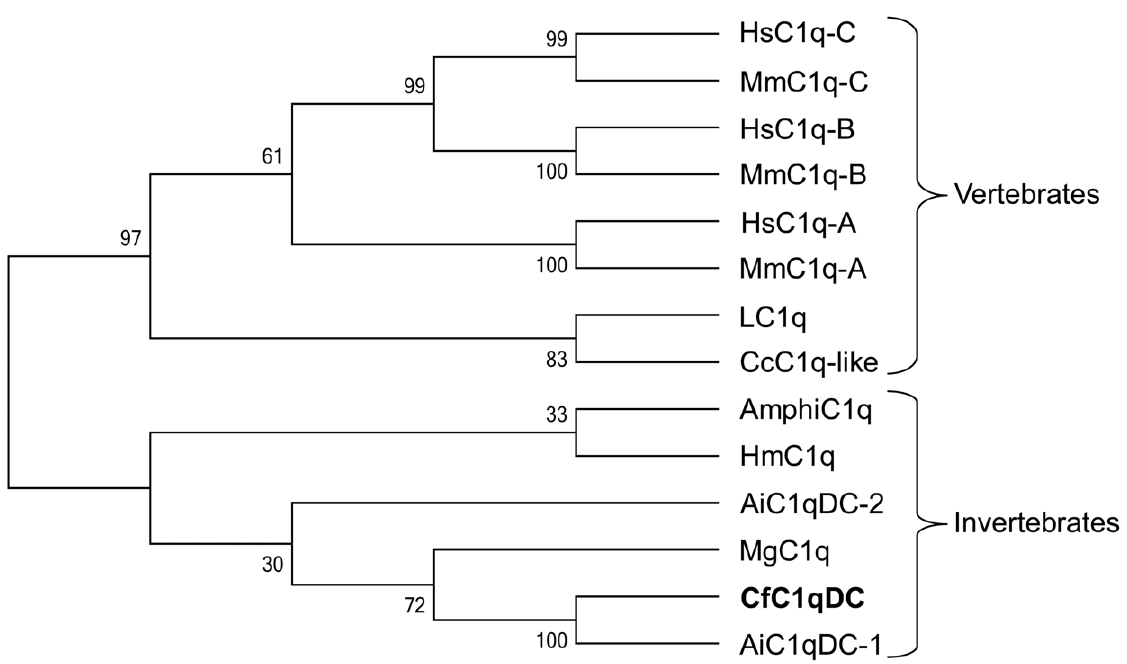
Figure 10. Phylogenetic tree of gC1q domains from different C1qDC proteins. The tree is constructed by the neighbor-joining (NJ) algorithm using the Mega 3.1 program based on the multiple sequence alignment by ClustalW. The reliability of the branching is tested by bootstrap re-sampling (1000 pseudo-replicates). The gC1q domain sequences used for phylogenetic analysis are as follows: Human C1q-A ( NP_057075 ), Human C1q-B ( NP _ 000482 ), Human C1q-C ( NP_758957 ), Mouse C1q-A ( NP_031598 ), Mouse C1q-B ( NP_033907 ), Mouse C1q-C ( NP_031600 ), LC1q ( BAD22833 ), CcC1q-like ( BAD22535 ), AmphiC1q ( ACH95418 ), HmC1q ( ACC69183 ), AiC1qDC-2 ( GU475114 ), MgC1q ( FN563147 ), CfC1qDC ( EF536358 ) and AiC1qDC-1 ( GU475113